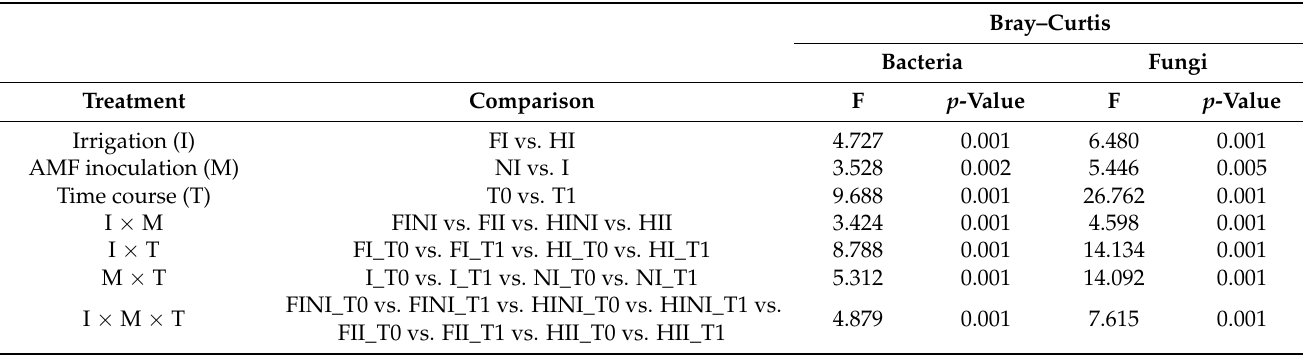
Table 1. F and p values of PERMANOVAs comparing different irrigation systems (I), AMF inoculation (M), and time course (T) of Merlot vineyard microbial beta diversity.